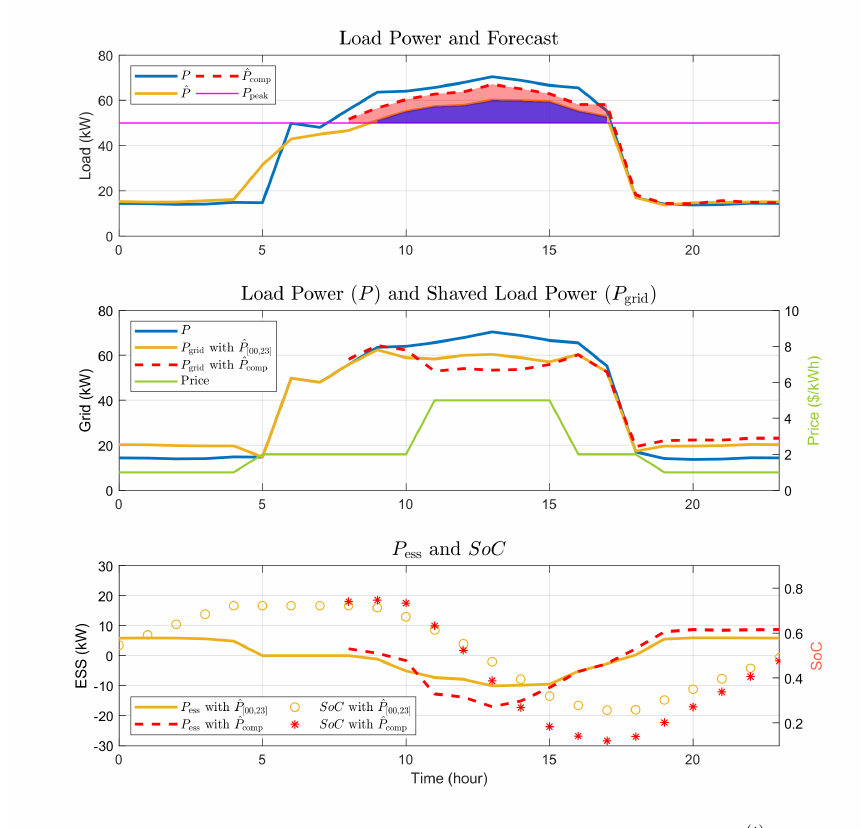
Figure 15. ESS scheduling results with different electricity price c ( t )